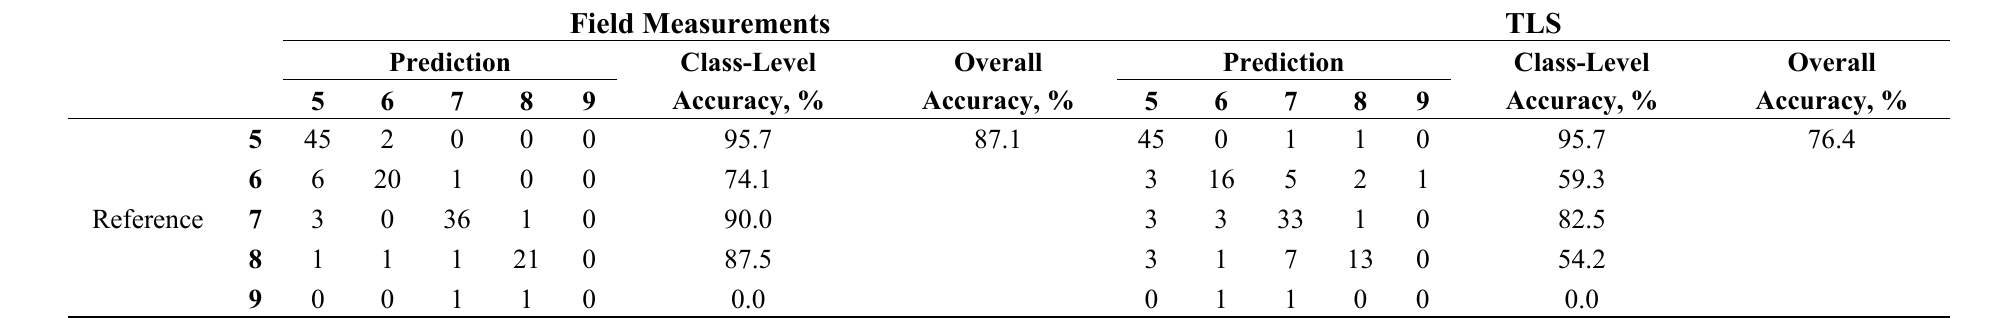
Table 5. Confusion matrix of five quality classes (reference vs. RF estimates), overall and class-level classification accuracies based on field ( left ) and TLS ( right )